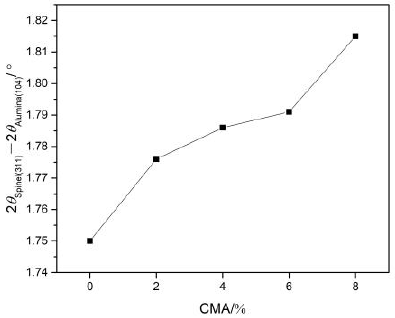
Figure 2. The shift of diffraction angle of spinel within samples sintered at 1600 ◦ C for 3 h. In general, all spinel can be defined as AB 2 O 4 . A 2+ and B 3+ cations occupy both tetrahedral and octahedral sites [35]. The cation inversion degree (x) represents the fraction of tetrahedral sites occupied by B 3+ cations [36]. The ratio of I (220) /I (440) was considered a measure of x because the intensity of diffraction peak I (220) was sensitive to the tetrahedral cations [37]. The lower the ratio of I (220) /I (440) is, the greater the inversion degree of cations is. When the Al 2 O 3 /MgO ratio increases, the inversion degree becomes larger. The higher ratios of I (220) /I (440) for samples G2-G8 can be seen in Figure 3, which indicate that the inversion degree of the spinel decreased with the addition of CMA. The lower inversion degree of spinel in dry ramming mixes is probably attributable to the difference in grain size [38]. Moreover, spinels including in situ formed and preformed CMA had various thermal his- tories. It was suggested that the adsorption behavior at the spinel – water interface was related to the defect structure of the spinel [39]. The influence of anti-site defects on the interaction between spinel and slag will be considered in future research. Figure 3. I (220) /I (440) of spinel within samples sintered at 1600 °C for 3 h. 3.2. Uncorroded Microstructure Figure 4 shows the microstructure of the G0, G4, and G8 samples after sintering at 1600 °C for 3 h. As seen in Figure 4a, there were many pores in sample G0. In contrast, samples G4 and G8 were denser because of the reduction in magnesia content in the ma- trix (Figure 4b,c).